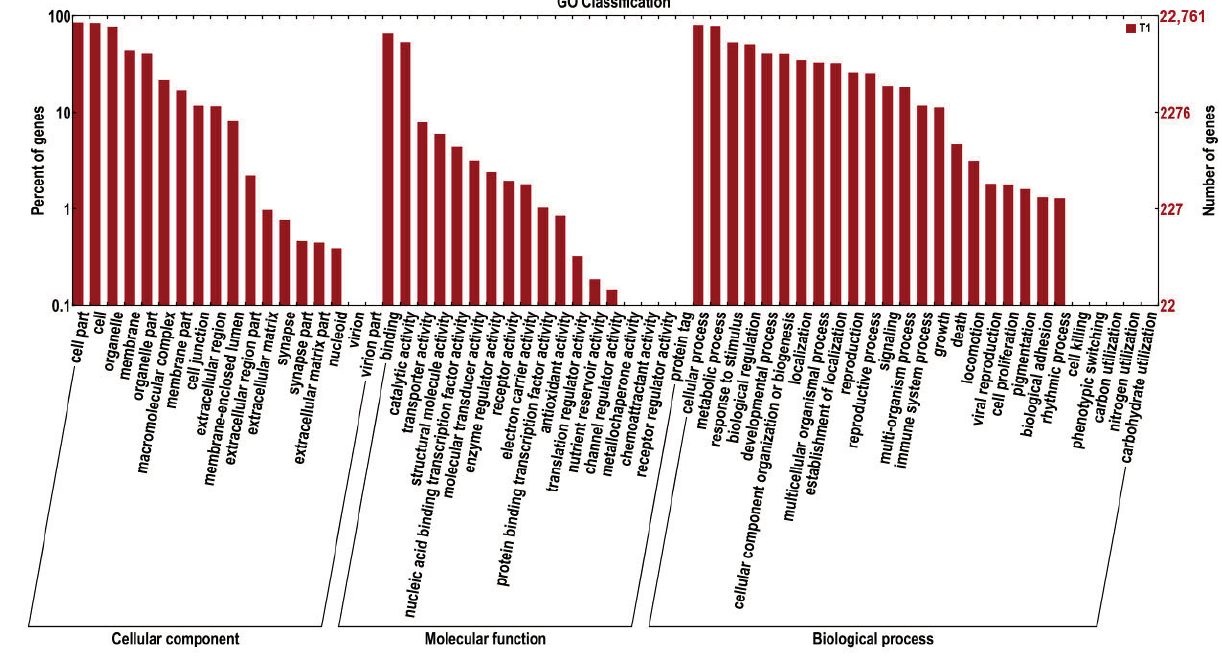
Figure 1. Gene Ontology (GO) classification of ramie roots transcriptome. The results are summarized in three categories: cellular component, molecular function and biological process. The y-axis on the right show the number of genes in category, and that on the left show the percentage of a specific category of genes in that main